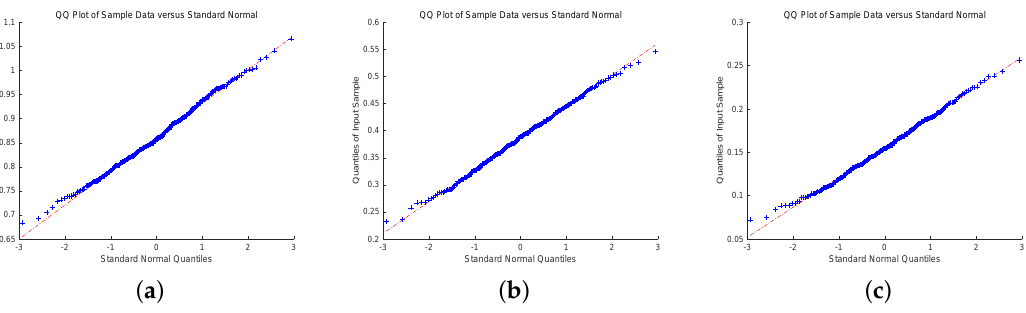
Figure 6. QQ-plot of ED for Combination-of-exponentials claim size density with T = 1440: ( a ) u = 1; ( b ) u = 3; ( c ) u =